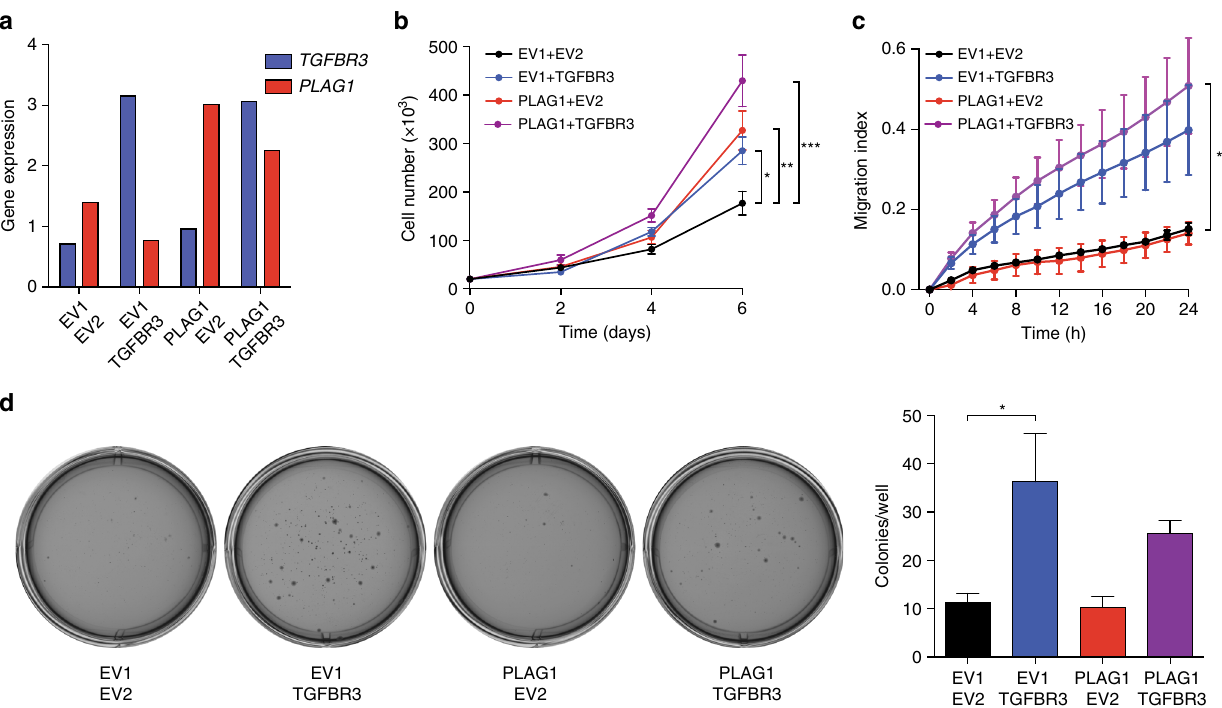
Fig. 3 Overexpression of TGFBR3 and PLAG1 causes transformation of human salivary gland (HSG) cells. a RT-QPCR of TGFBR3 and PLAG1 mRNA levels in HSGs infected with constructs expressing combinations of PLAG1 or the corresponding empty vector ( EV ) 1, and TGFBR3 or the corresponding EV2 . Data are mean using three technical replicates, normalized to the reference gene STLM . b Proliferation. Data are mean ± SEM using three technical replicates. * P < 0.05, ** P < 0.01, *** P < 0.001; two-way ANNOVA with Dunnett ’ s multiple comparison test. The experiment was replicated three times. c Migration index. Data are mean ± SEM using four technical replicates. * P < 0.05; two-way ANNOVA with Dunnett ’ s multiple comparison test. The experiment was replicated two times. d Representative photographs (left) and quanti fi cation (right) of soft agar colony formation. Data are mean ± SEM from three technical replicates. * P < 0.05; one-way ANNOVA with Tukey ’ s multiple comparison test. The experiment was replicated two